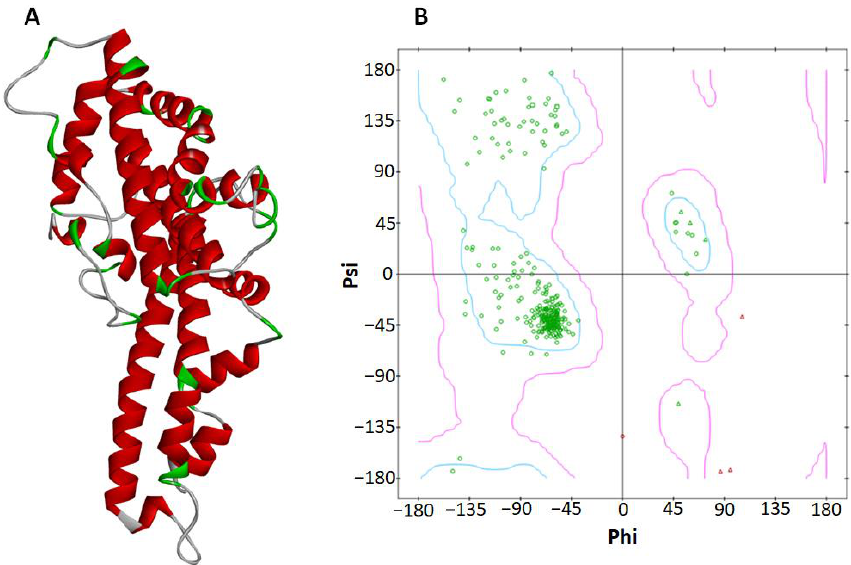
Figure 2. The 3D structure of P. vivax DBP after energy minimization is shown on the right ( A ). The ( B ) Ramachandran graph exhibiting that all of the amino acid residues are in the permitted zone and there are no outliers.